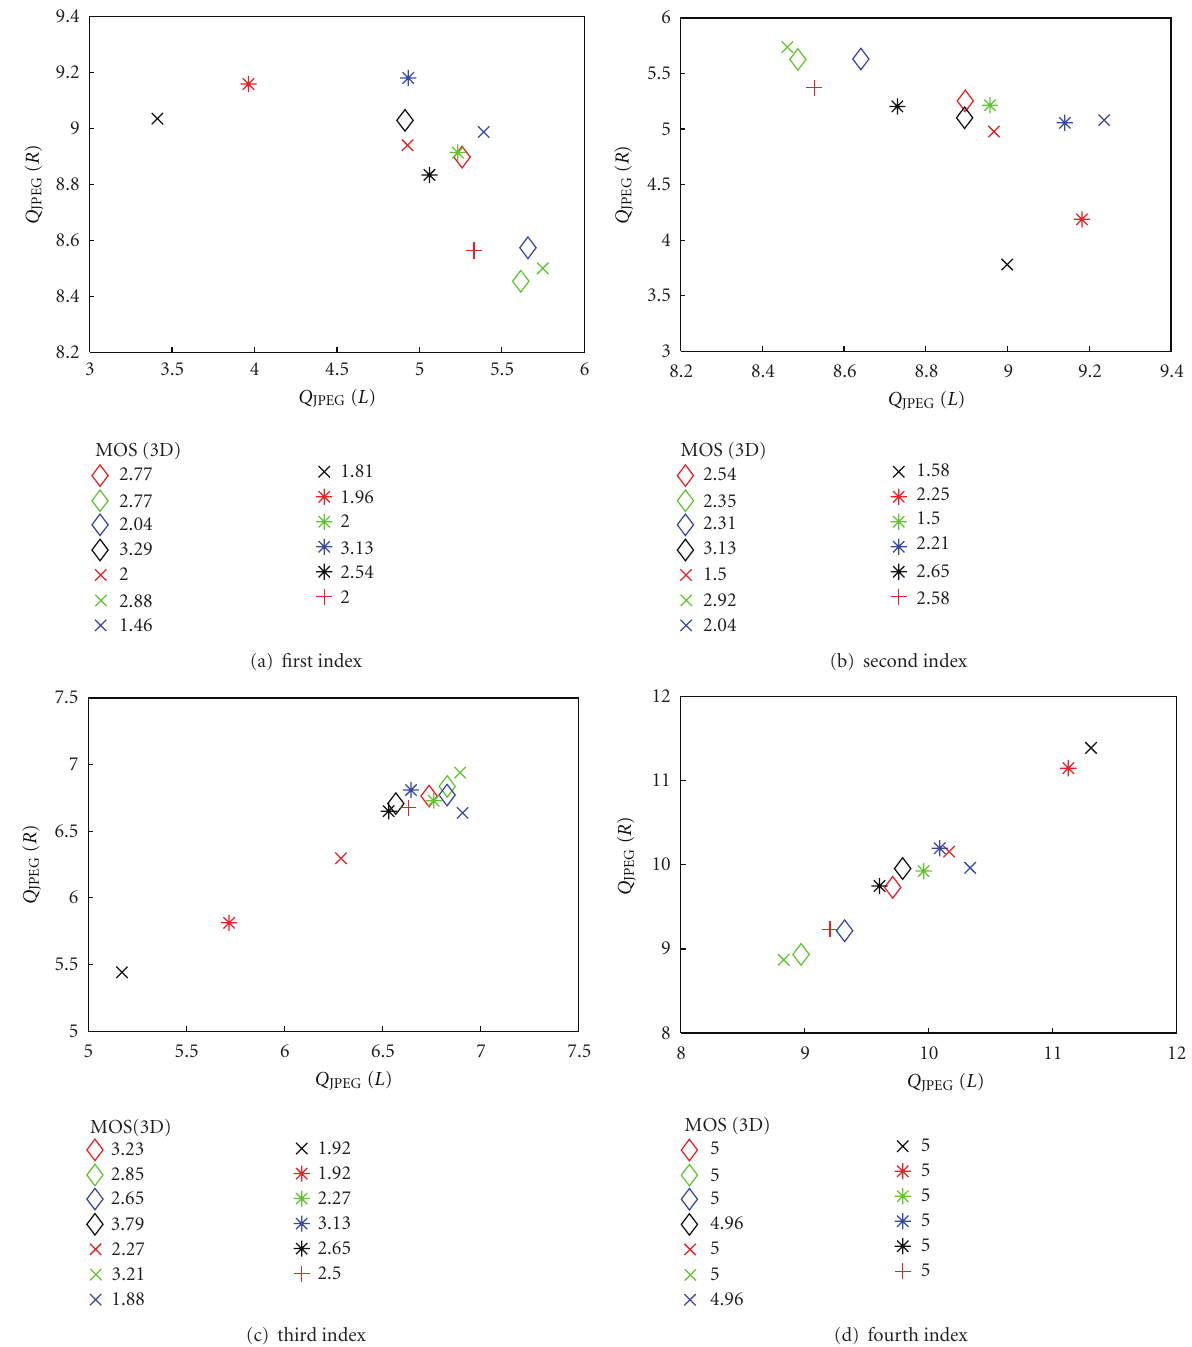
Figure 4: Illustration of the (a) first index; (b) second index; (c) third index; (d) fourth index of image pairs in Table 1. Q JPEG ( L ) and Q JPEG ( R ) are predictions of left and right image qualities by [6], and MOS(3D) indicates MOS values of stereoscopic images.